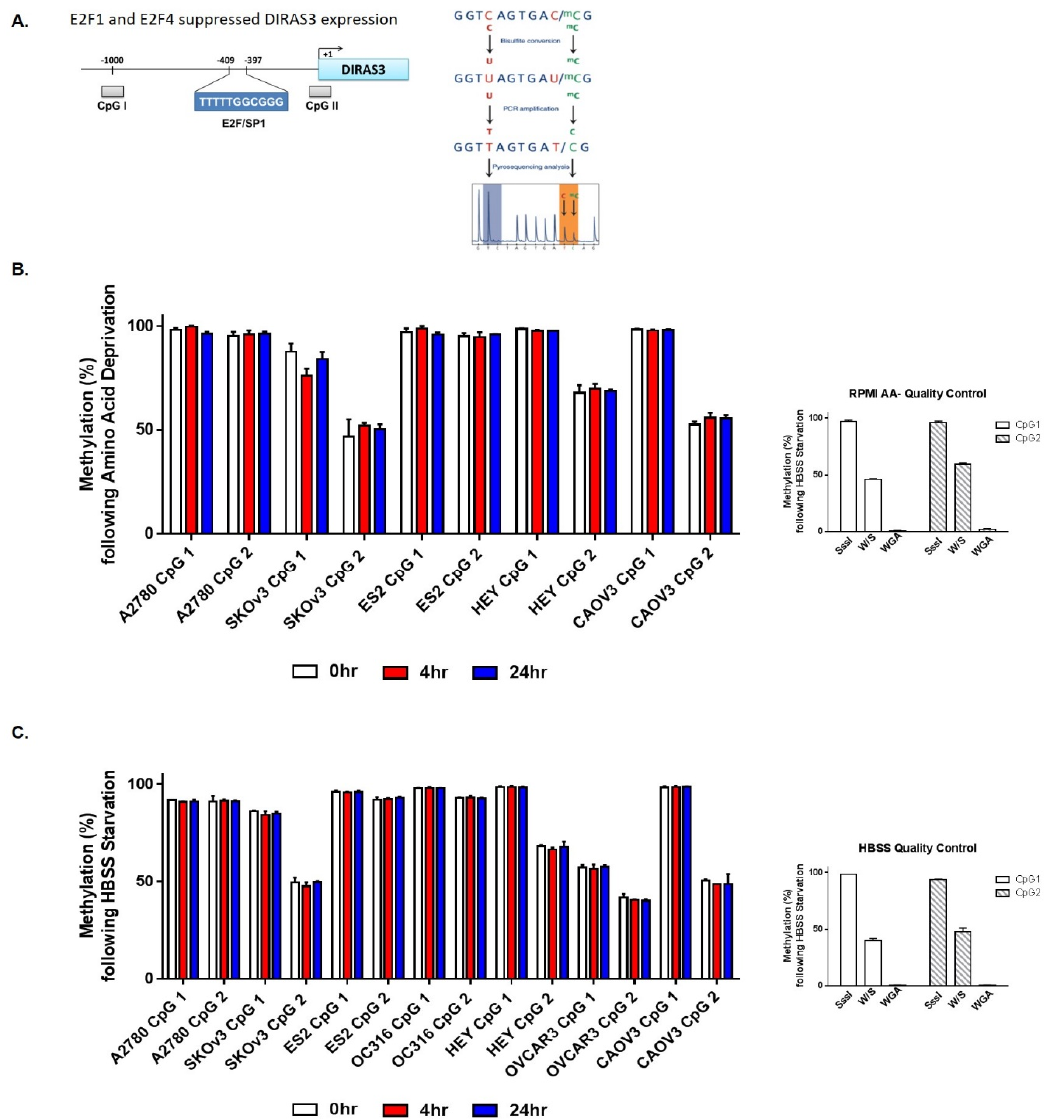
Figure A2. Methylation status of DIRAS3 does not change following amino acid deprivation. ( A ) Schematic depicting pyrosequencing process. Genomic DNA was collected following amino acid ( B ) or serum deprivation ( C ) for 0–24 h in several ovarian cancer cell line and pyrosequencing was performed. Graphs indicate the percent methylation at CpG island 1 or CpG island 2.